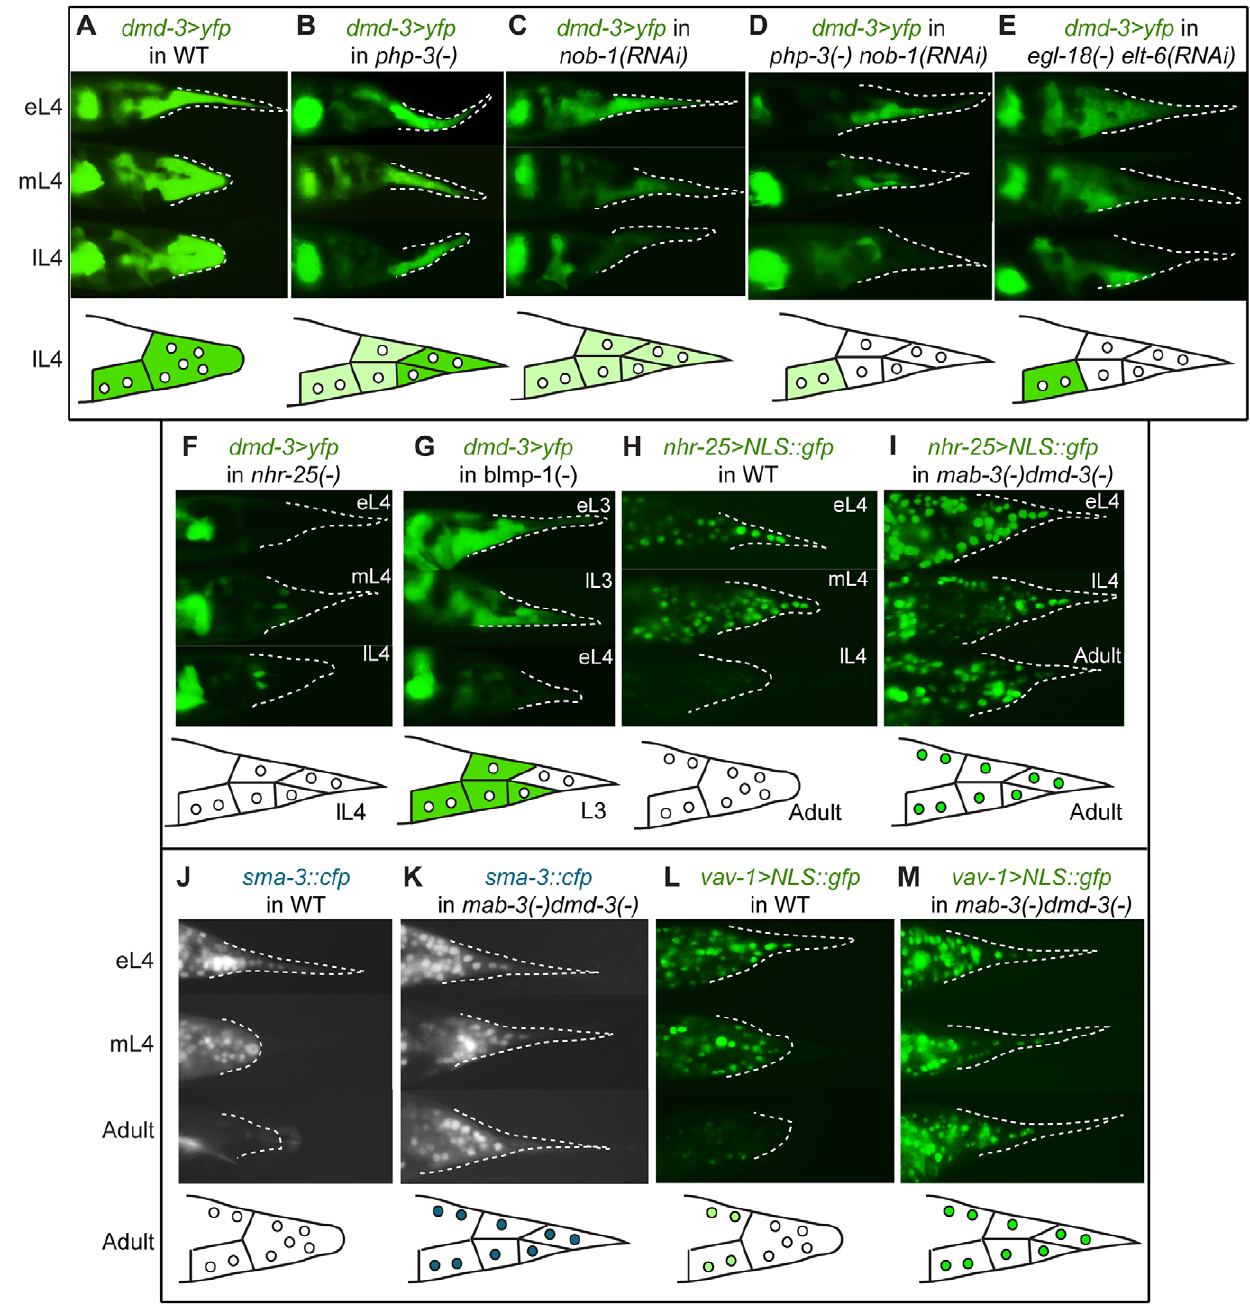
Figure 6. Expression epistasis experiments to test interactions between key regulatory genes. In the top of each panel are fluorescent micrographs of male tails (lateral views) at three of several stages (eL3 = early L3, lL3 = late L3, eL4 = early L4, mL4 = mid-L4, lL4 = late L4, or adult) expressing various transgenes in different genetic backgrounds. At the bottom of each panel is a schematic depicting the expression pattern at one exemplar stage. (A) Expression of a dmd-3 . yfp transcriptional reporter in wild-type males. (B–G) Effects on the expression of dmd-3 . yfp by RNAi- depletion or mutations of other genes (note that tail tip morphogenesis is impaired in these RNAi-treated or mutant males and rounding of the tail tip in lL4 does not occur). (B) Loss of php-3 function in ok919 mutant animals causes reduced dmd-3 . yfp expression in hyp8, hyp11 and hyp13. (C) Depletion of nob-1 by RNAi causes reduced dmd-3 . yfp expression in hyp8–11. (D) php-3(ok919) nob-1(RNAi) animals show no dmd-3 . yfp expression in hyp8-11. (E) Although dmd-3 . yfp is initially expressed in egl-18(ok290) elt-6(RNAi) animals, it shuts off prematurely in hyp8–11. (F) Expression of dmd-3 . yfp is never initiated in the tail tip cells of nhr-25(ku217) reduced-function mutants. (G) blmp-1(tm548) mutants show precocious expression of dmd-3 . yfp in eL3 in hyp8, hyp9 and hyp11, no expression in hyp10, and premature inactivation of dmd-3 . yfp at early L4. (H) nhr-25 . NLS::gfp is expressed brightly prior to and at the beginning of morphogenesis and is quickly inactivated near its end. (I) In mab-3(e1240);dmd-3(ok1327) animals, expression of the nhr-25 reporter remains bright in adult males. (J) SMA-3::CFP is expressed and nuclearly localized in hyp8–11 during morphogenesis and is not visible in adult males (the image shows autofluorescence of the spicules and the fan). (K) In mab-3(e1240);dmd-3(ok1327) adults, expression of the sma-3::cfp reporter remains very bright into adulthood. (L) vav-1 . NLS::gfp is expressed brightly in hyp8–11 and in other cells of the tail prior to and during morphogenesis and at extremely low levels in adults. (M) Expression of the vav . NLS::gfp reporter remains very bright in hyp8–11 and the other cells of the male tail in adult mab-3(e1240);dmd-3(ok1327) animals.